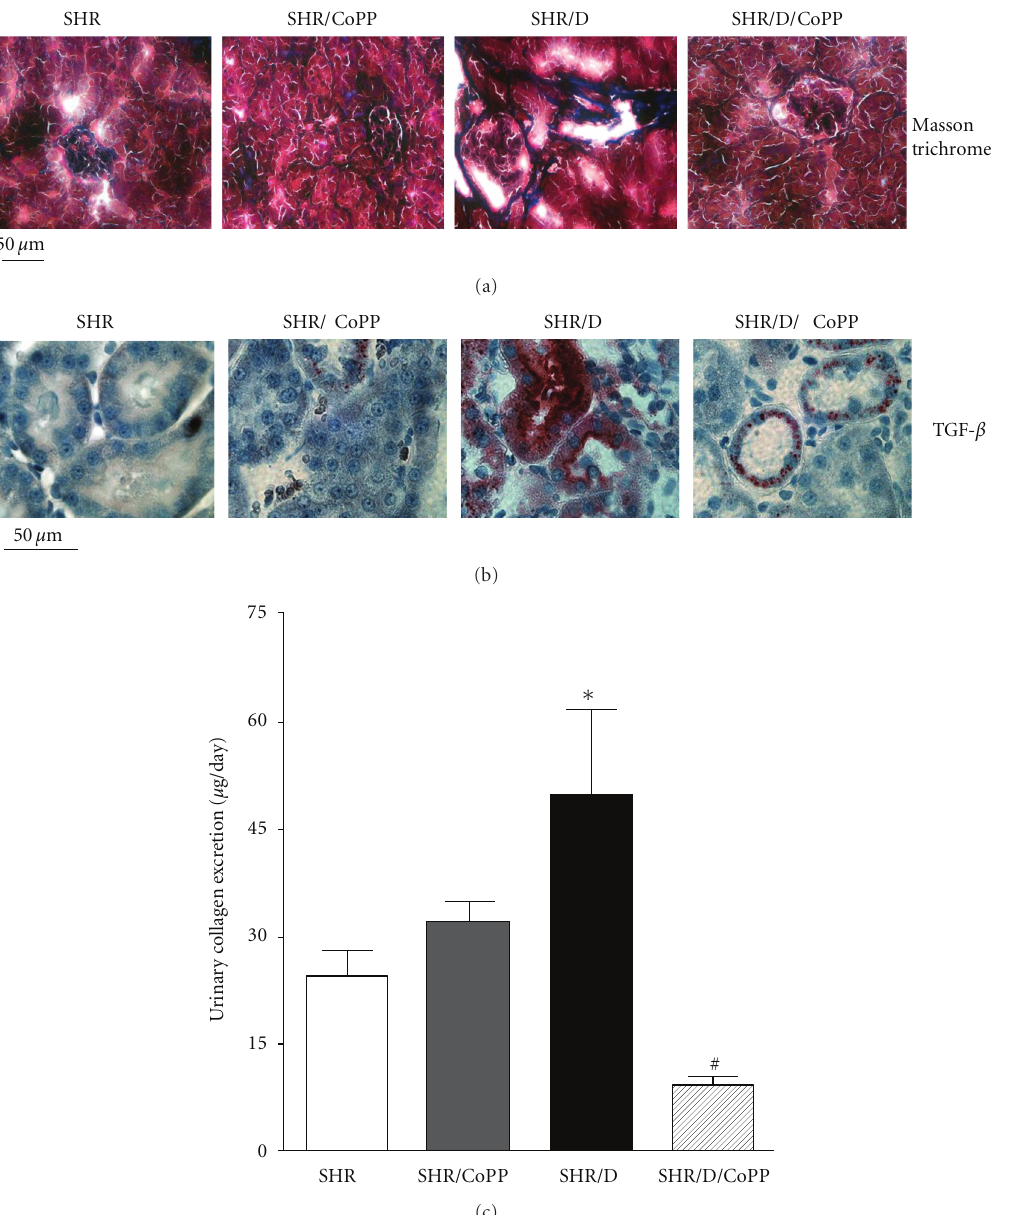
Figure 3: Representative images of Masson’s trichrome staining (a) and immunohistochemical staining of TGF- β (b) in kidney sections from control and diabetic SHR with or without CoPP treatment ( n = 5). (c) is urinary collagen excretion in control and diabetic SHR with or without CoPP treatment ( n = 8, ∗ indicates significant di ff erence from control SHR and # indicates significant di ff erence from diabetic